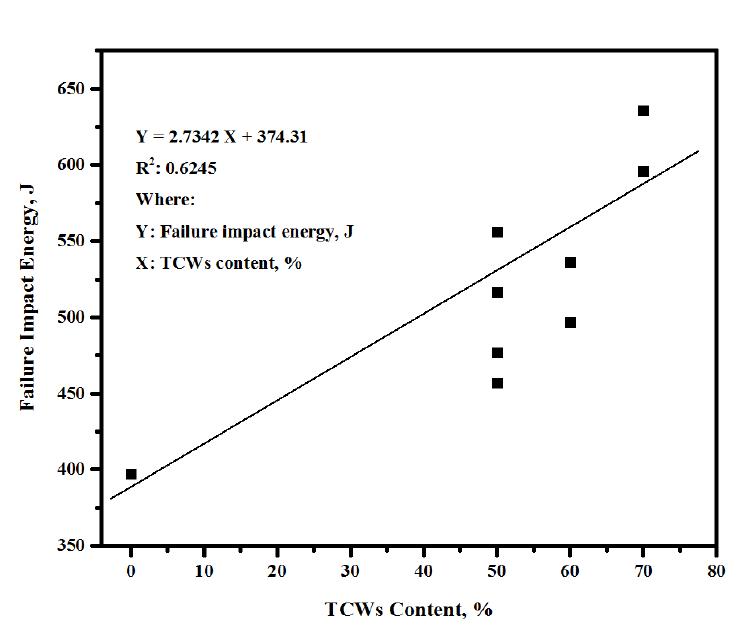
Figure 15. Relationship between TCWs content and impact energy capacity at failure stage.